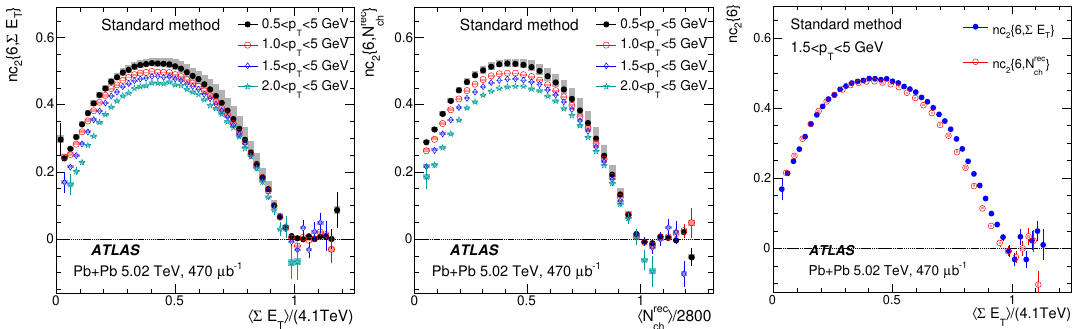
Figure 17 . The normalized six-particle cumulants nc 2 f 6 ; (cid:6) E T g as a function of h (cid:6) E T i (left panel) and nc 2 f 6 ; N rec g as a function of h N rec i (middle panel) in four p T ranges. The nc 2 f 6 ; (cid:6) E T g and ch ch nc 6 f 4 ; N rec g results for 1 : 5 < p T < 5 GeV are also compared directly as a function of h (cid:6) E T i (right ch panel). The error bars and shaded boxes represent the statistical and systematic uncertainties, respectively. Zero is indicated by a dotted